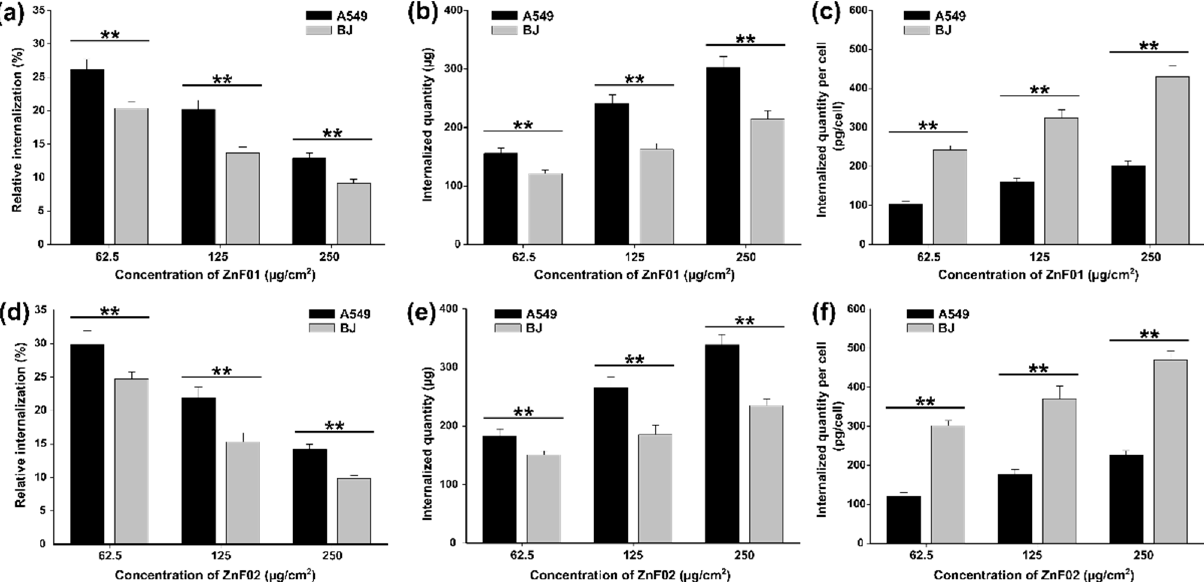
Figure 9. Cellular internalization of ZnF01 ( a – c ) and ZnF02 ( d – f ) in A549 and BJ cells after a 24 h exposure; ( a , d ) the relative internalization; ( b , e ) the total amount of ZnF01/ZnF02 internalized in A549 and BJ cells; ( c , f ) the internalized quantity of ZnF01/ZnF02 per cell. The values are expressed as mean ± SD of at least three biological replicates. Double asterisks (**) indicate significant differences (ANOVA + Dunn’s; p < 0.001).